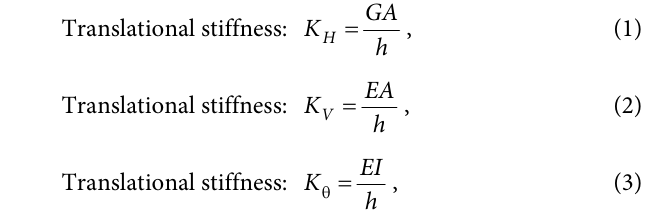
Fig. 5. Elastomeric Bearing Pad Model